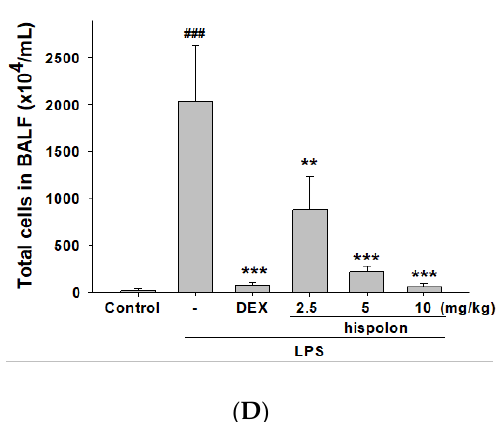
Figure 2. Hispolon improved ( A ) pulmonary edema (W/D ratio) and ( B ) Myeloperoxidase (MPO) activity, and decreased ( C ) cell counts and ( D ) total protein in the bronchoalveolar lavage fluid (BALF). Lung tissues were measured by calculating the W/D ratios. Total cells and total proteins of BALF were assessed. Data are presented as means ± S.E.M. (n = 6). ### p < 0.001 versus the control group. * p < 0.05, ** p < 0.01 and *** p < 0.001 versus the lipopolysaccharide (LPS) group.